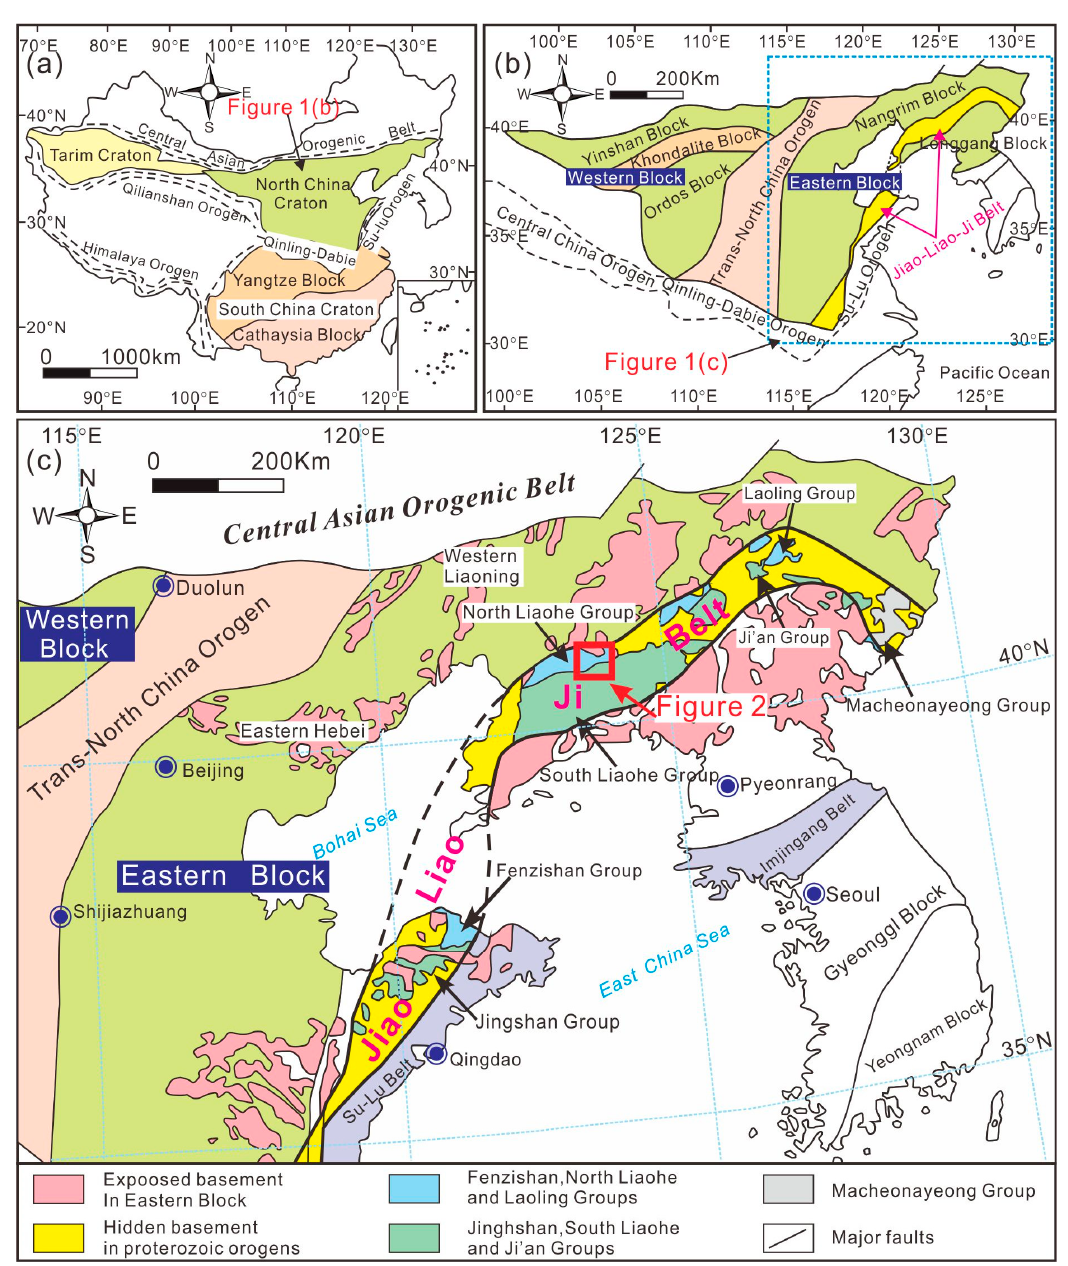
Figure 1. ( a ) Major structural distribution map of China. ( b ) Geological map of the North China Craton, and ( c ) the Paleoproterozoic Jiao-Liao-Ji Belt (after Zhao et al. [3]).